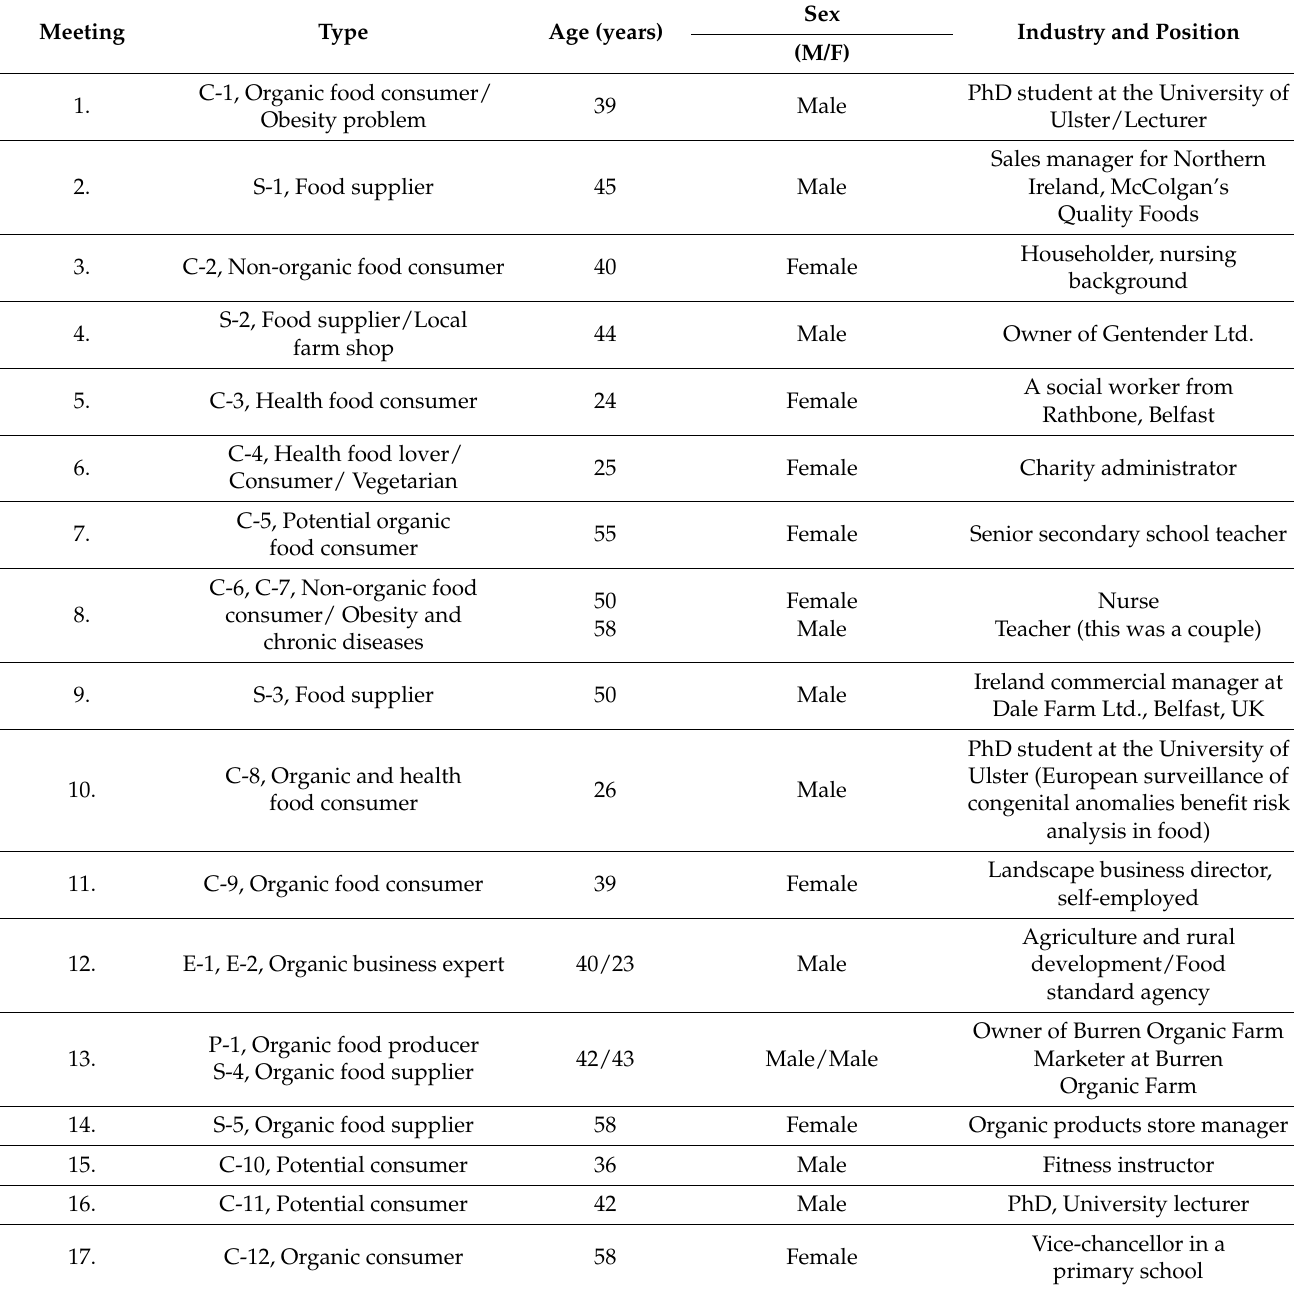
Table 1. List of interviewees * in the